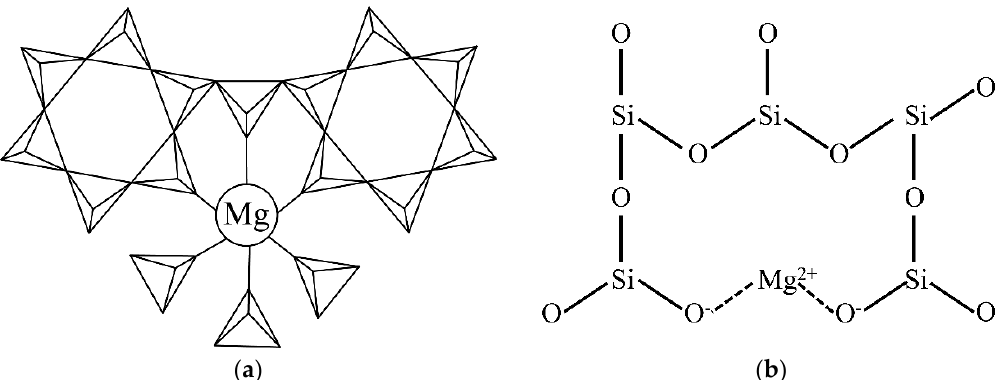
Figure 5. Two-dimensional diagram of different Mg 2+ connection in ( a ) cordierite (triangles with lines inside represent [SiO 4 ] and [AlO 4 ] tetrahedrons) and ( b ) the amorphous phase (The Si–O bond perpendicular to the paper is not shown for watching convenience).